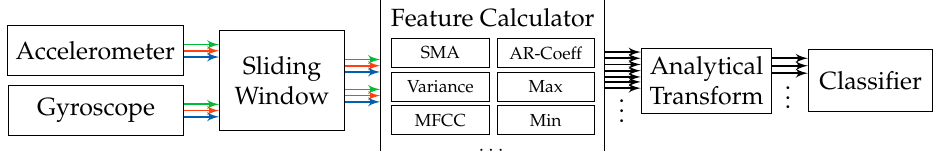
Figure 8. Flow diagram of the pattern recognition pipeline employed for the approach based on statistical features. Accelerometer and gyroscope output the three streams x-axis (green), y-axis (blue), z-axis (red), which are processed independently throughout the pipeline until their features are concatenated for